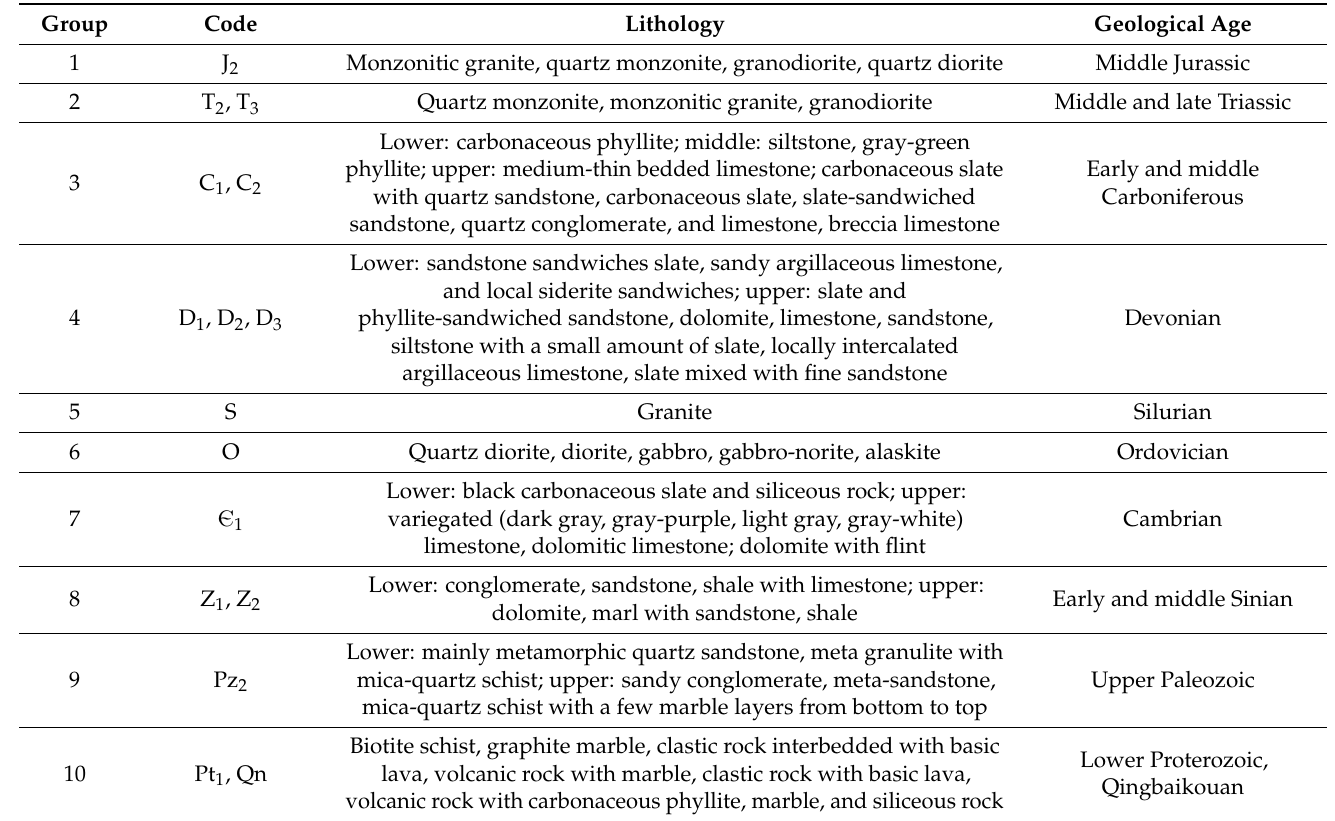
Table 1. Description of the groups of